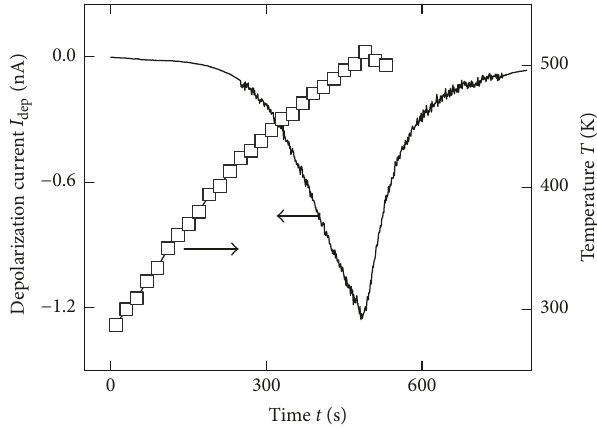
Figure 6: Kinetics of the temperature 𝑇 and the depolarization current 𝐼 for the MOM stack based on the YSZ film with 𝑑 = dep 40 (5) , and of the dep